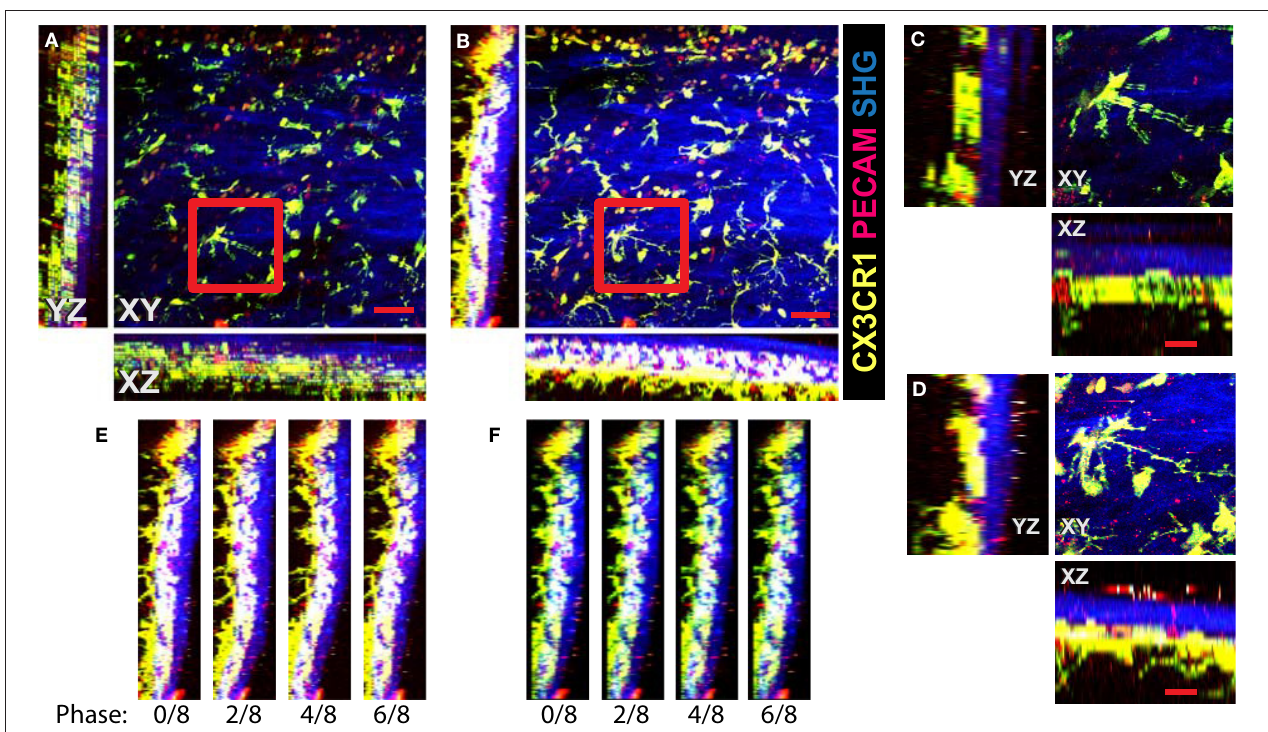
FIGURE 4 | Image acquisition with the VivoFollow 2 system in the 2P-IVM imaging of the cervical spinal cord (SC) vasculature of mice. Maximum intensity projection (MIP) of the SC vasculature images in CX3CR1-GFP//CCR2-RFP reporter mouse. (A) Usual acquisition without triggering. Duplicates of the fine processes of GFP + microglial cells are visible in XY projection (red frame). Due to severe motion, the depth information is incoherent and practically lost. Scale bar is 50 µ m. (B) Acquisition of each Z frame is synchronized to respiration using TrigViFo. Three-dimensional volume continuity is recovered. (C,D) Zoom on the highlighted regions from (A,B) correspondingly. Scale bar is 20 µ m. (E) YZ MIPs of the same region acquired at four different phases of respiration. Significant “wavy” distortion is present. (F) Same YZ MIPs after distortion correction. Smooth lining of the tissue is